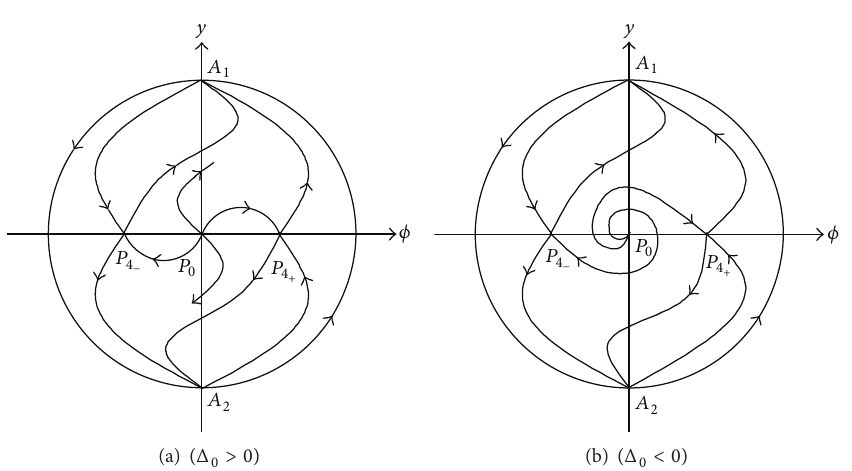
Figure 2: ( 𝛽 > 0 , 𝑎 < 0 , 𝑏 = 0 , 𝑐 < 0